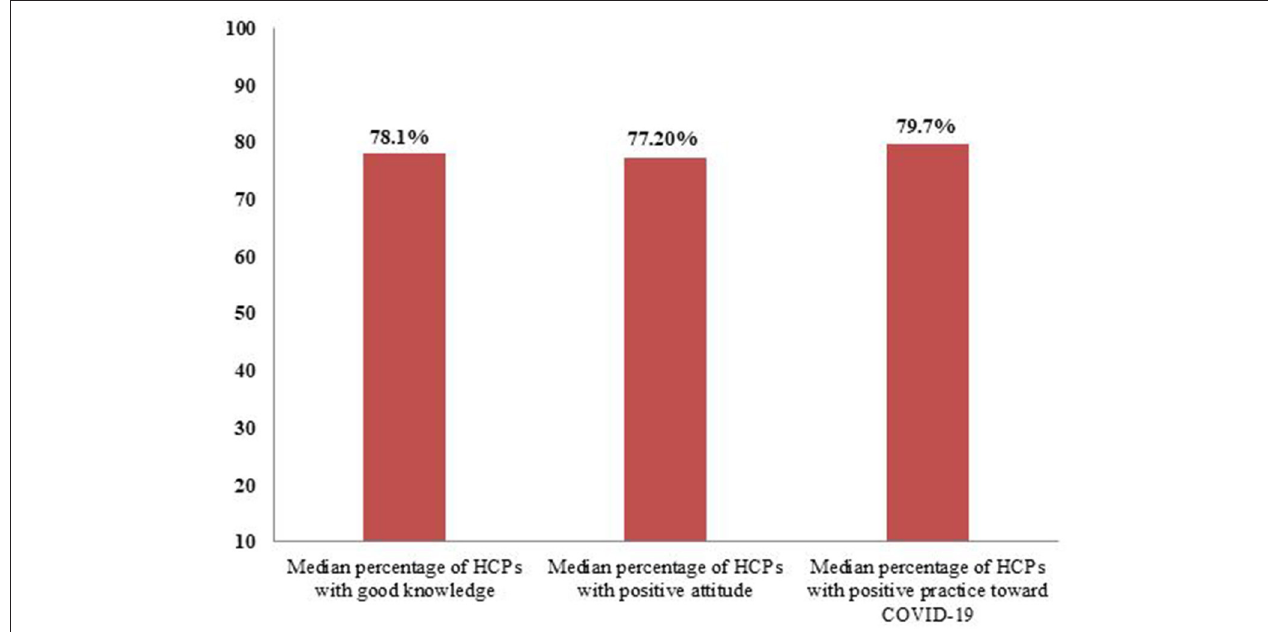
FIGURE 2 | Median percentage of HCPs with good knowledge and positive attitude and practice toward